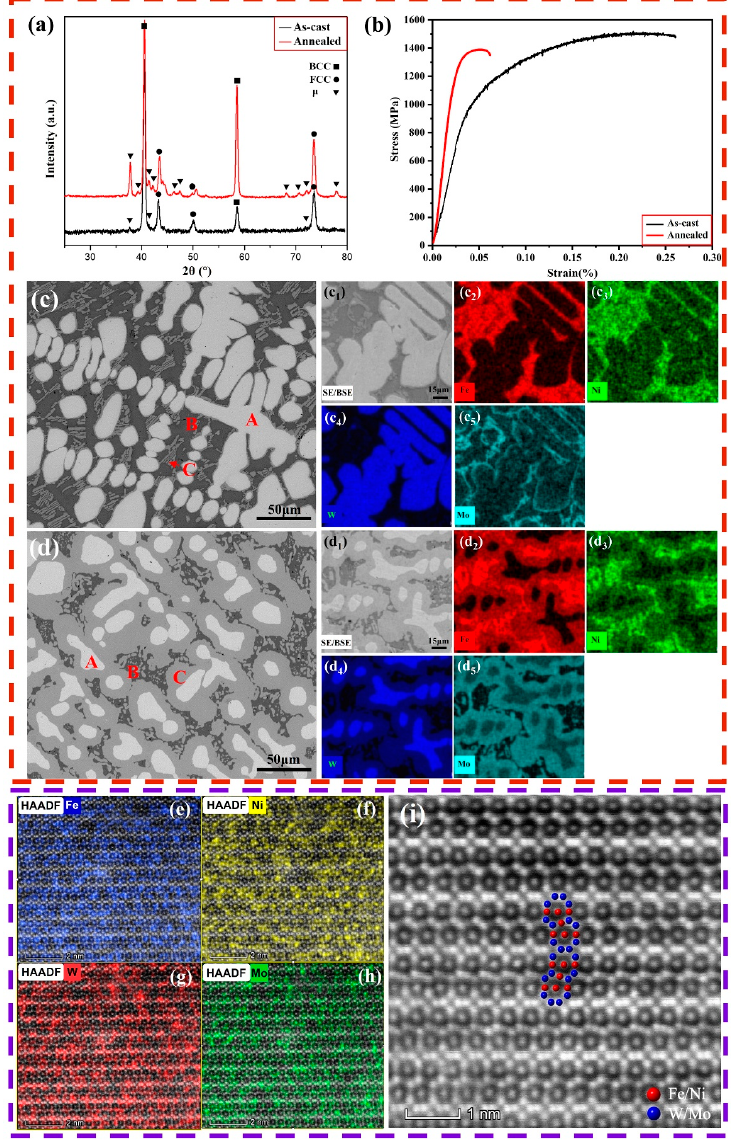
Figure 1. ( a ) XRD patterns of the as-cast and annealed specimens; ( b ) stress–strain curves of the as-cast and annealed specimens; ( c ) SEM image of the as-cast specimen, where ( c 1 – c 5 ) show the morphology and elemental distribution of the as-cast specimen; ( d ) SEM image of the specimen after annealing at 1150 °C for 24 h, whereas ( d 1 – d 5 ) show the morphology and elemental distribution of the annealed specimen; ( e – h ) EDS maps of the μ phase for Fe, Ni, W, and Mo elements using STEM; and ( i ) STEM lattice image of the μ phase.